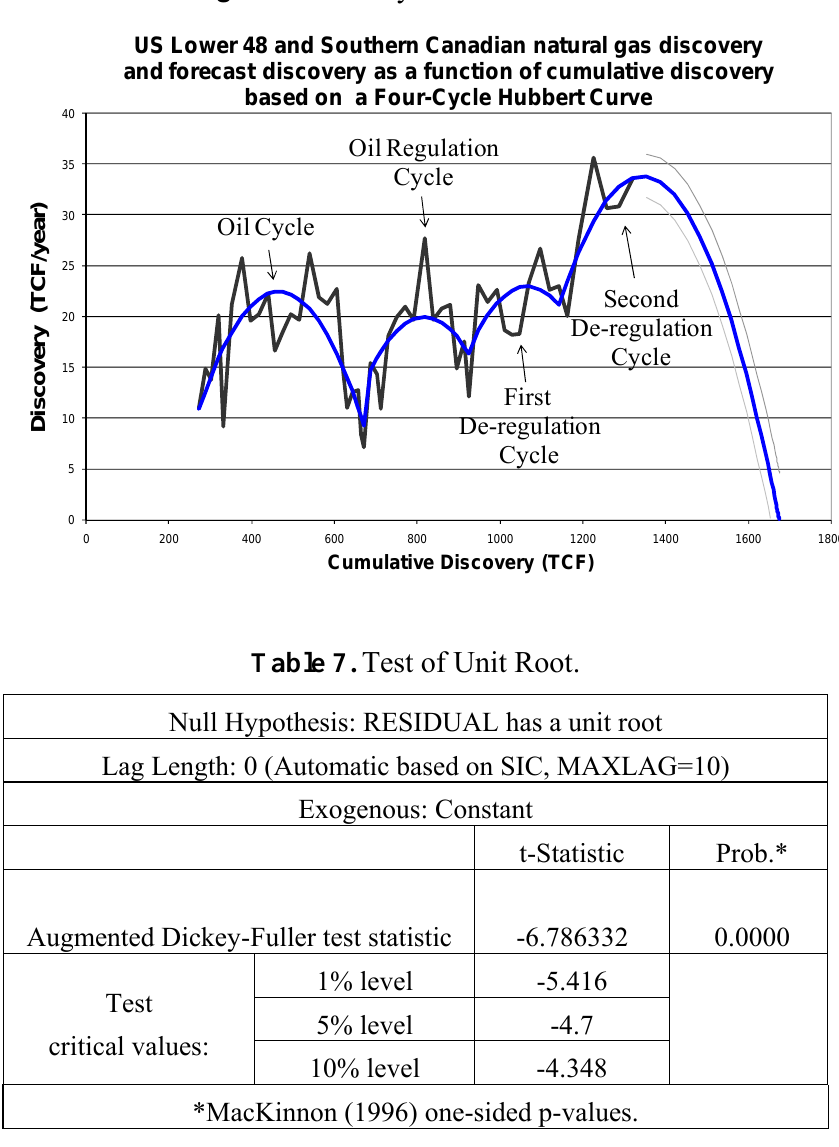
Figure 3. Four Cycle Hubbert Curve.